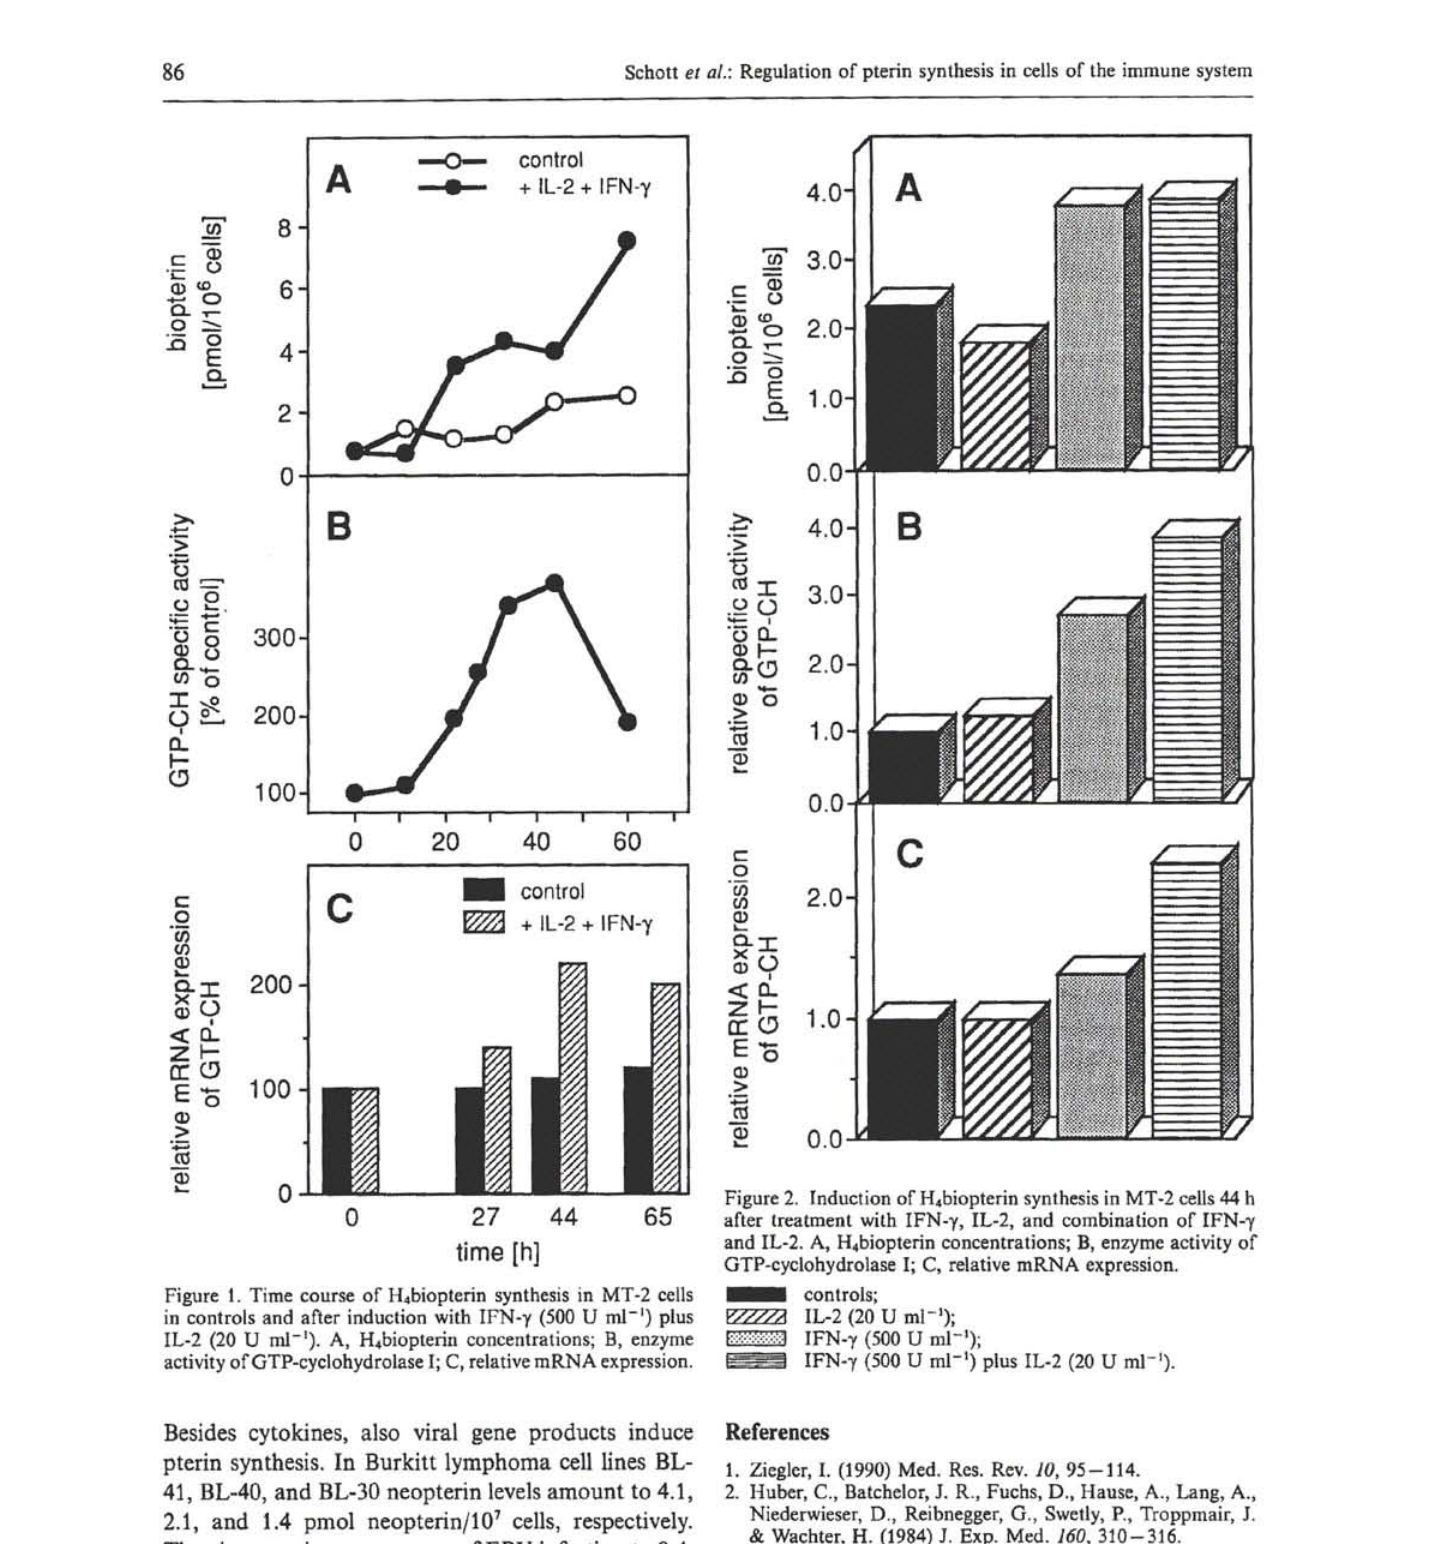
Figure 2. Induction of H 4 biopterin synthesis in MT-2 cells 44 h after treatment with IFN-y, IL-2, and combination of IFN-γ and IL-2. A, H 4 biopterin concentrations; B, enzyme activity of GTP-cyclohydrolase I; C, relative mRNA expression. H ·· controls; V////Á IL-2 (20 U ml-'); (&.'..v.%1 IFN-γ (500 U ml-'); t—tr=) IFN-γ (500 U ml" 1 ) plus IL-2 (20 U ml" 1 ).